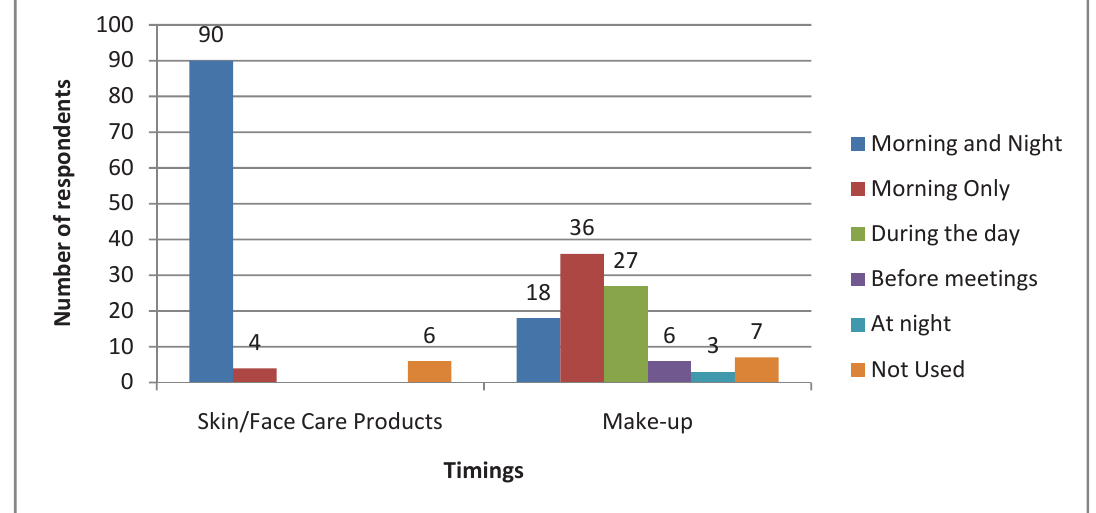
Fig. 3. Frequency of using